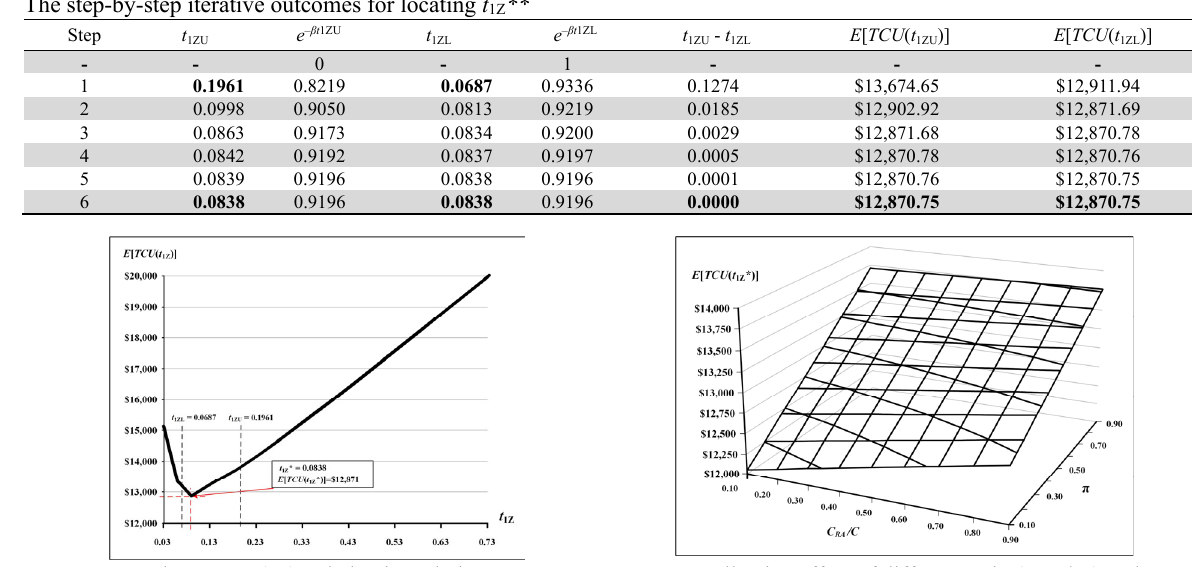
Fig. 7. The E [ TCU ( t 1Z )]’s behavior relating to t 1Z Fig. 8. Collective effect of differences in ( C RA / C ) and π